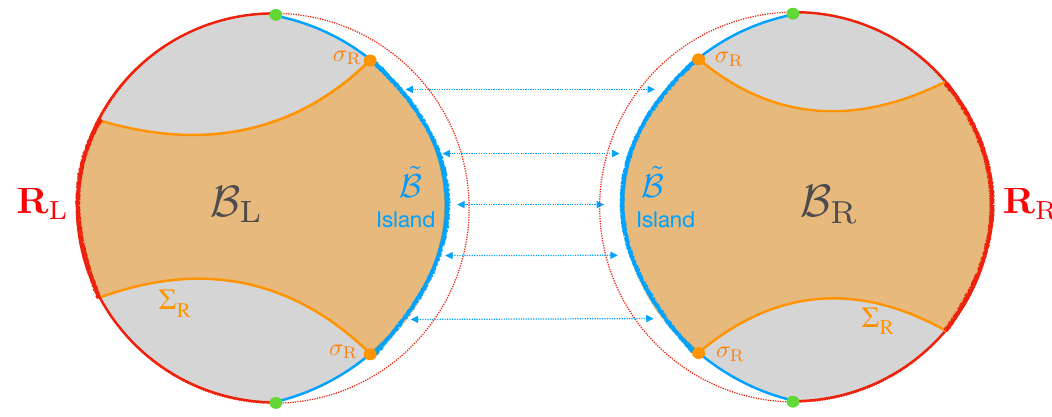
Figure 2 . The holographic setup with islands in AdS d +1 . The two AdS d +1 geometries are cut off at θ = θ B (or z = z B ) and glued together with the brane at the junction between the two. The island region emerges on the brane when the RT surfaces Σ cross the brane. The maximal volume bulk slice B = B of these two surfaces determines the island ˜ B = B ∩ brane = B